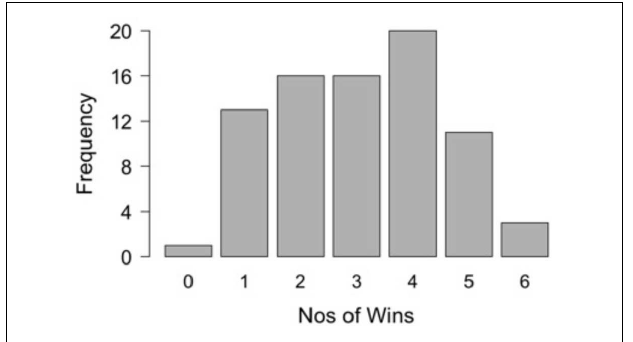
FIGURE 1 | Frequency distribution of participant’s wins in Connect 4.